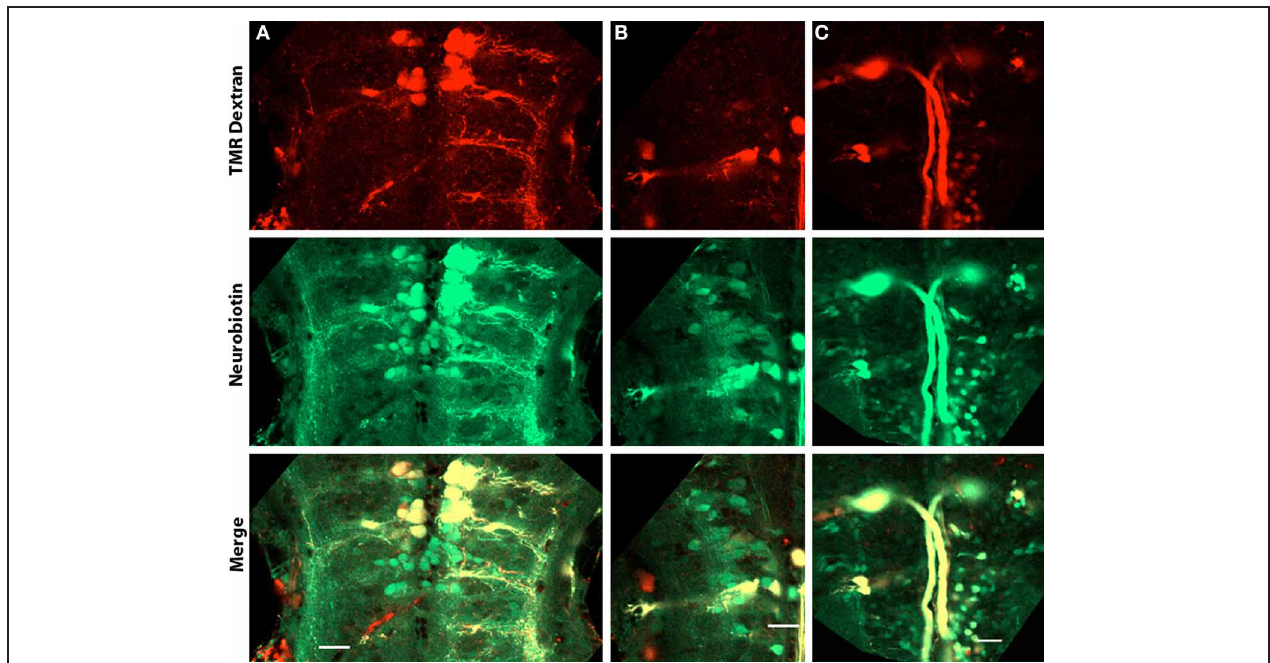
rhodamine dextran (red). Cells electrically coupled to the labeled neurons but not projecting into the spinal cord are green in color, while the neurons that project into the spinal cord are yellow because of the presence of both neurobiotin and tetra methyl rhodamine dextran. Scale bar for all panels: 20 µ